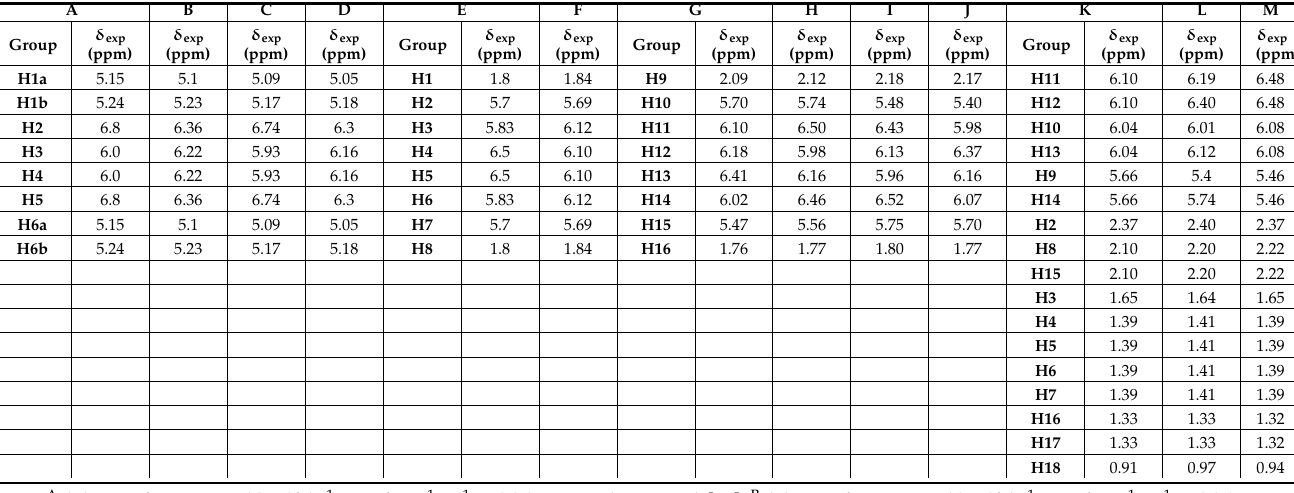
Table 1. Literature experimental 1 H NMR chemical shifts, δ exp , and the sample and spectral specifications of the compounds of Figure